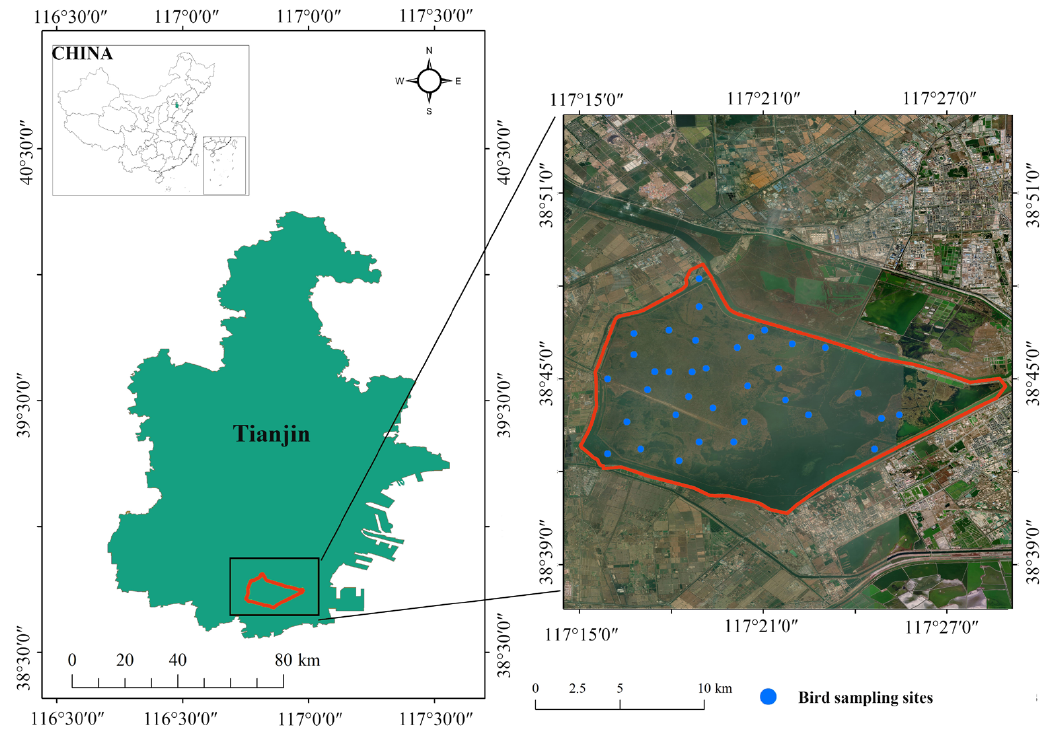
Figure 1. Maps of bird survey sites. The red line is Beidagang Reservoir’s boundary line, and the blue dots are sampling sites.